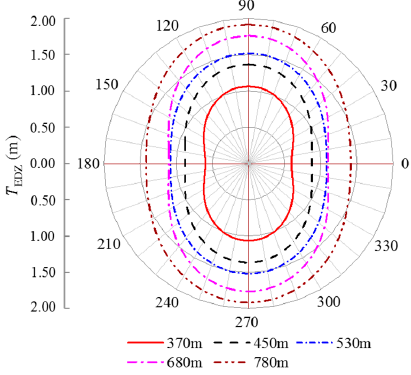
Figure 6. The thickness of EDZs based on the Hoek–Brown criterion.